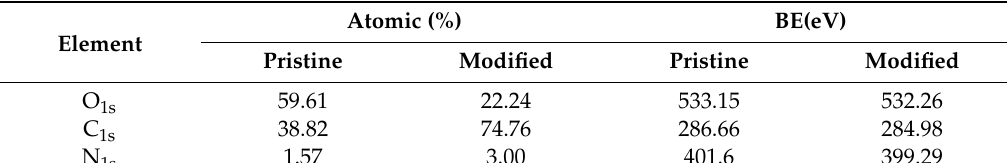
Table 2. Atomic percentage and binding energy (BE) of elements O, C, and N of pristine and modified fabrics.